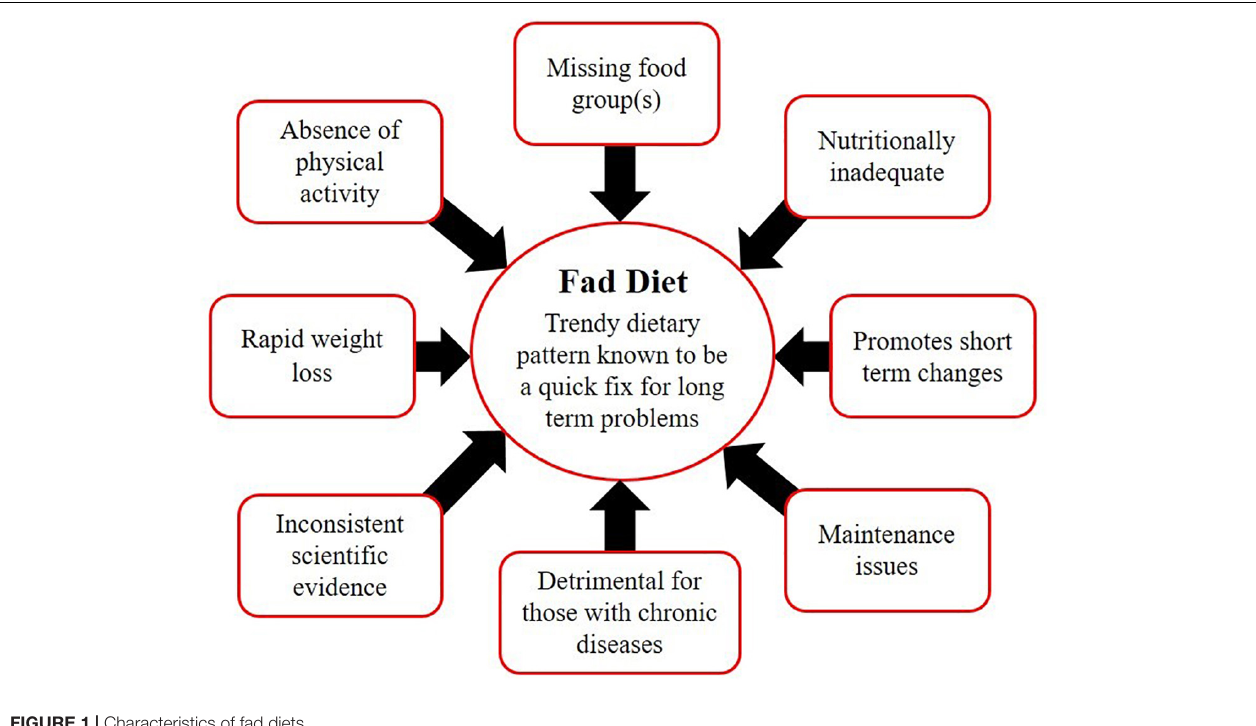
FIGURE 1 | Characteristics of fad diets.